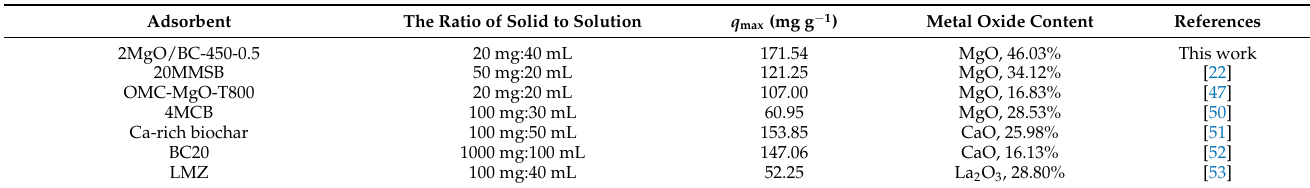
Table 2. The maximum phosphorus adsorption capacity of different adsorbents at room temperature from existing literature and in this work.